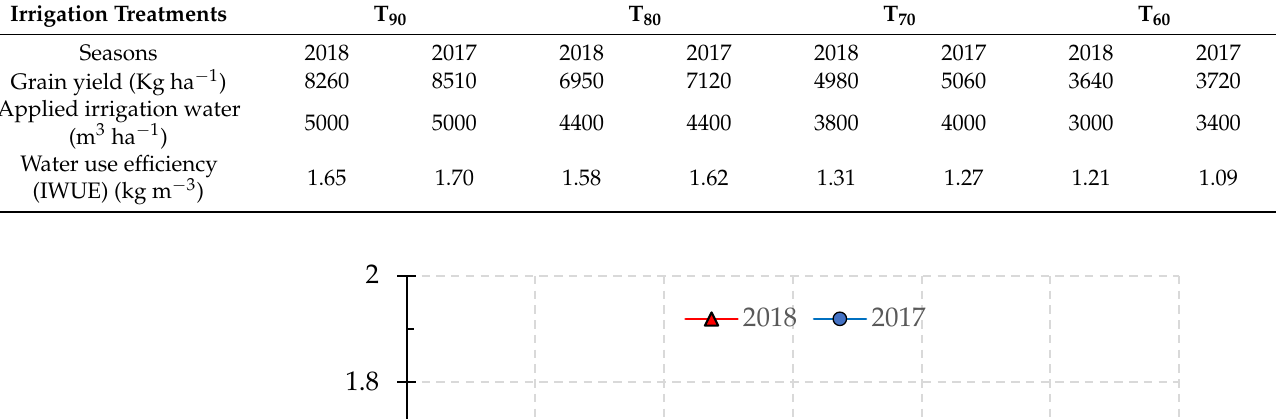
Table 8. Grain yield and irrigation water use efficiency (IWUE) for different irrigation treatments (T 90 , T 80 , T 70 , and T 60 ). Irrigation